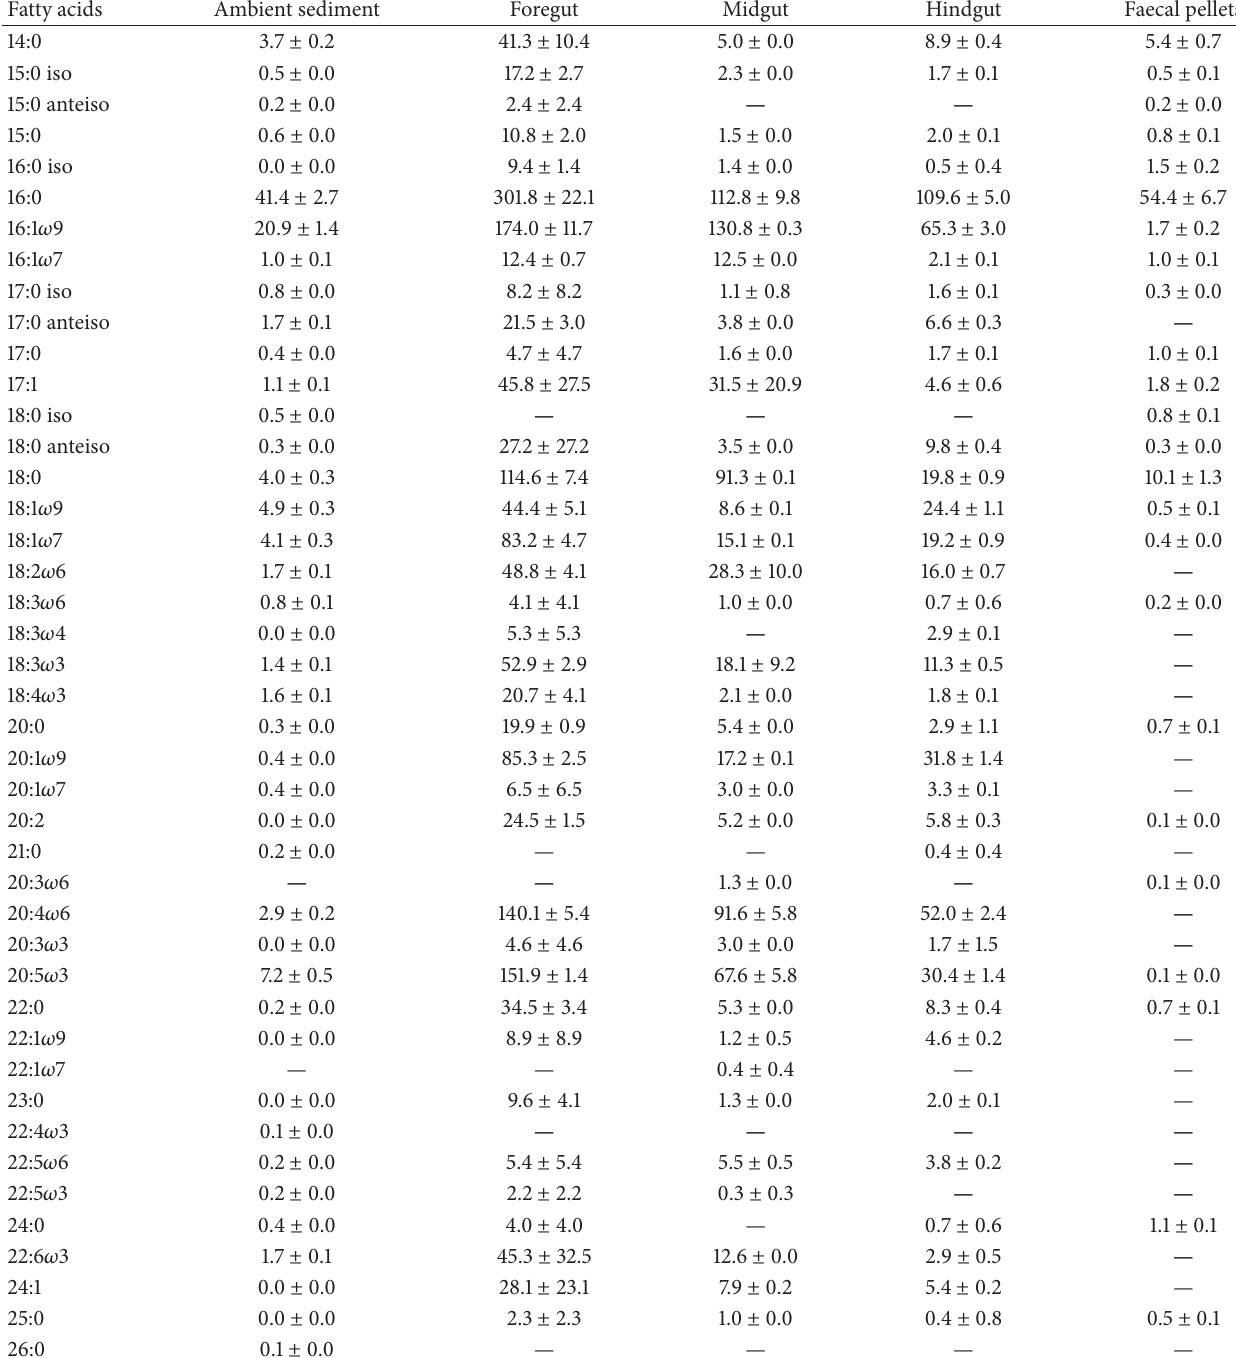
Table 1: Fatty acid composition ( 𝜇 gg −1 dry weight) of ambient sediment, foregut, midgut, hindgut, and faecal pellets of Holothuria atra . Fatty acids Ambient sediment Foregut Midgut Hindgut Faecal